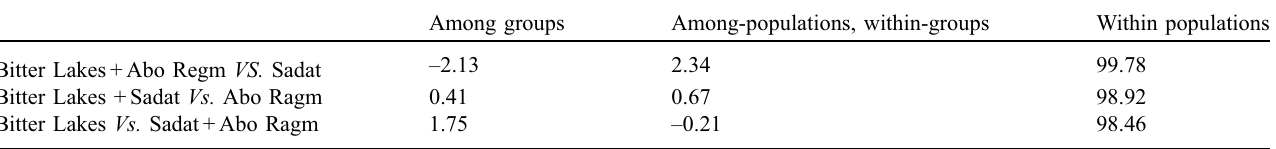
Figure 4. Few other haplotypes were shared among the sampling areas. These were Hap2, which was present in both BL and AR (BL + AR), Hap 5 (BL + AR), Hap 7 (BL + AR), and Hap 15 (SA + AR). Singleton haplotypes (i.e. private ones) were present in the three studied locations, ranging in percentage from 50% of total haplotypes present in BL, to about. 80% of total haplotypes are present in SA area. The singleton haplotypes in SA and AR slightly outnumbered these in BL (Tab. 2, Fig. 4). For the world haplotype network, two main groups were identi fi ed; one included the Arabian Plate populations, and the other included all the Indo-West Paci fi c populations (Fig. 5).